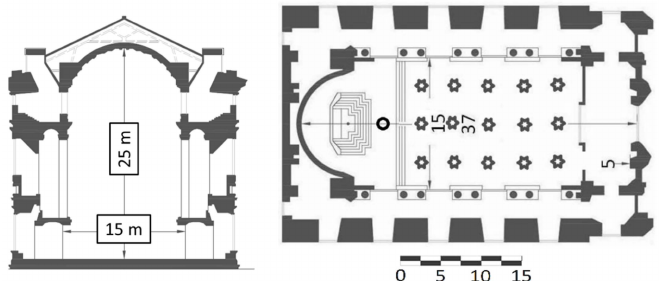
Figure 3. Cross section and plan of the Palatine Chapel, with location of the sound source ( ) and of the receivers (